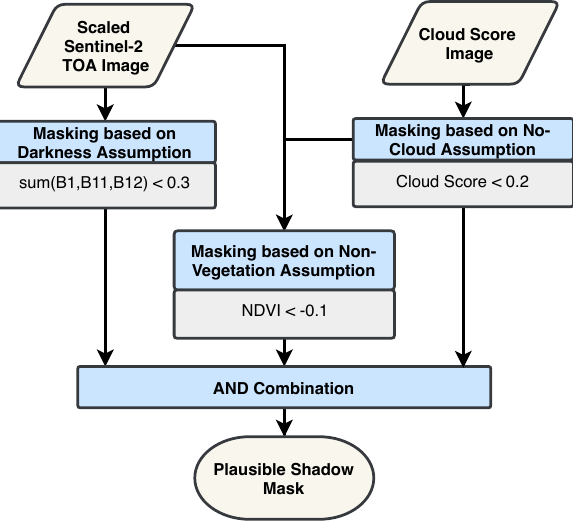
Figure 5. Flowchart of the Plausible Shadow Mask submodule, which is needed to provide input to the Shadow Score submodule.